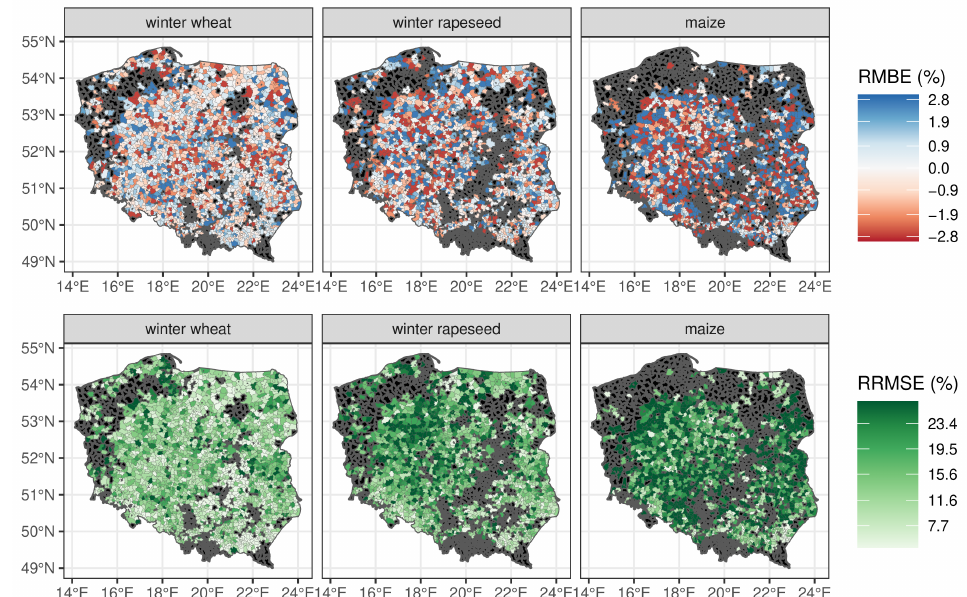
Figure 13. Map of crop yield forecasts performance at the LAU level. Black areas denote LAU units where the crop yield forecast was not possible due to data availability